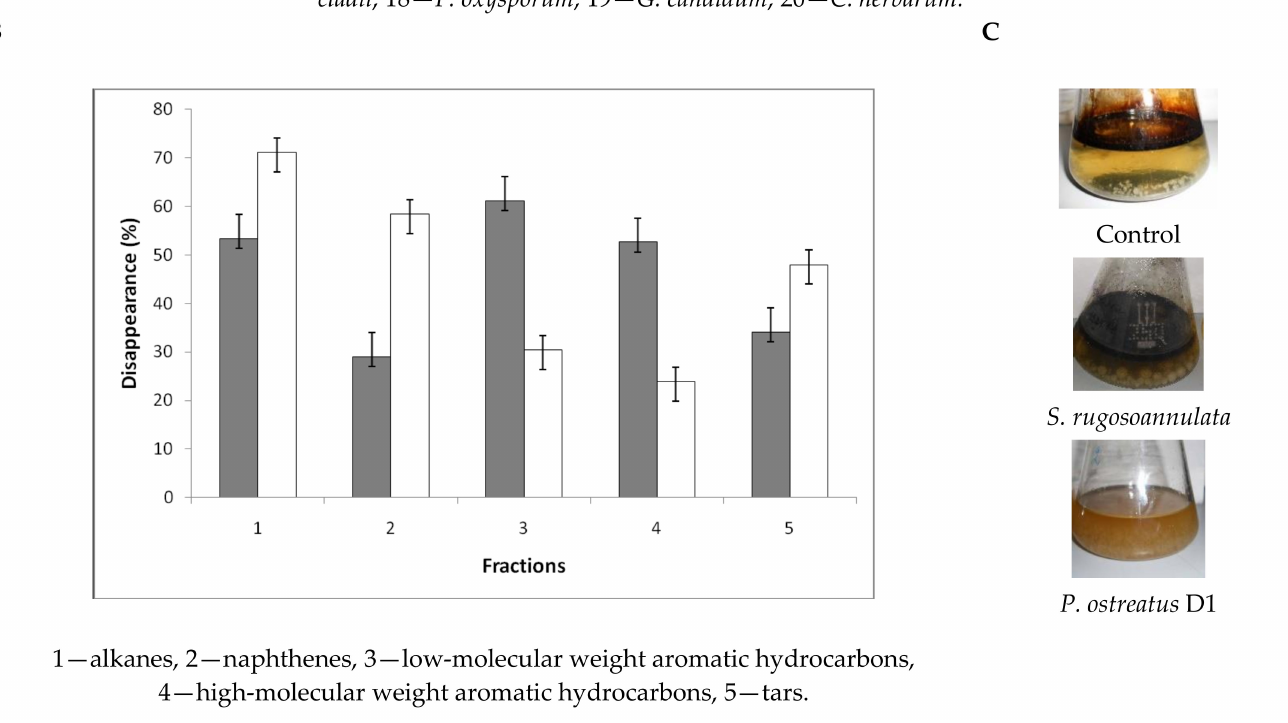
Figure 6. Effect of PAHs and their fungal metabolites on germination of seeds ( □ ), length of shoots Figure 3. Oil disappearance by studied fungi ( A ), disappearance of fractions of oil degradation ( ■ ), and length of roots ( ■ ) of sorghum: ANT—anthracene, ANTQ—9,10-anthraquinone, PHE— during growth of P. ostreatus D1 ( ) and Str. rugosoannulata ( (cid:3) ) in basidiomycetes-rich medium ( B ), and the fungal growth ( C phenanthrene, PHEQ—phenanthrene-9,10-quinone, FLU –fluorene, FLU-on—9-fluorenone, CBA— 2-carboxybenzaldehyde, DIPH—2,2 ′ -diphenic acid, PHTH—phthalic acid.